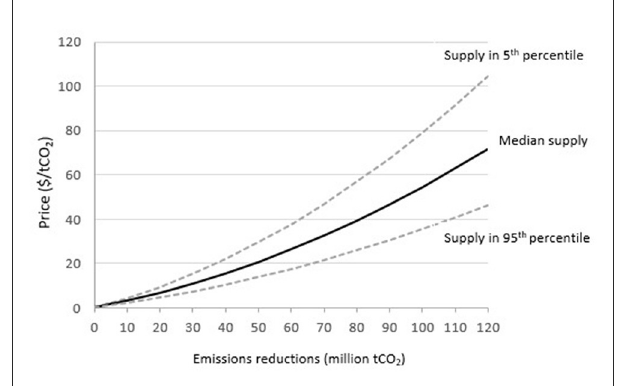
FIGURE1 Uncertainty range of jurisdictional abatement supply (90th confidence interval).